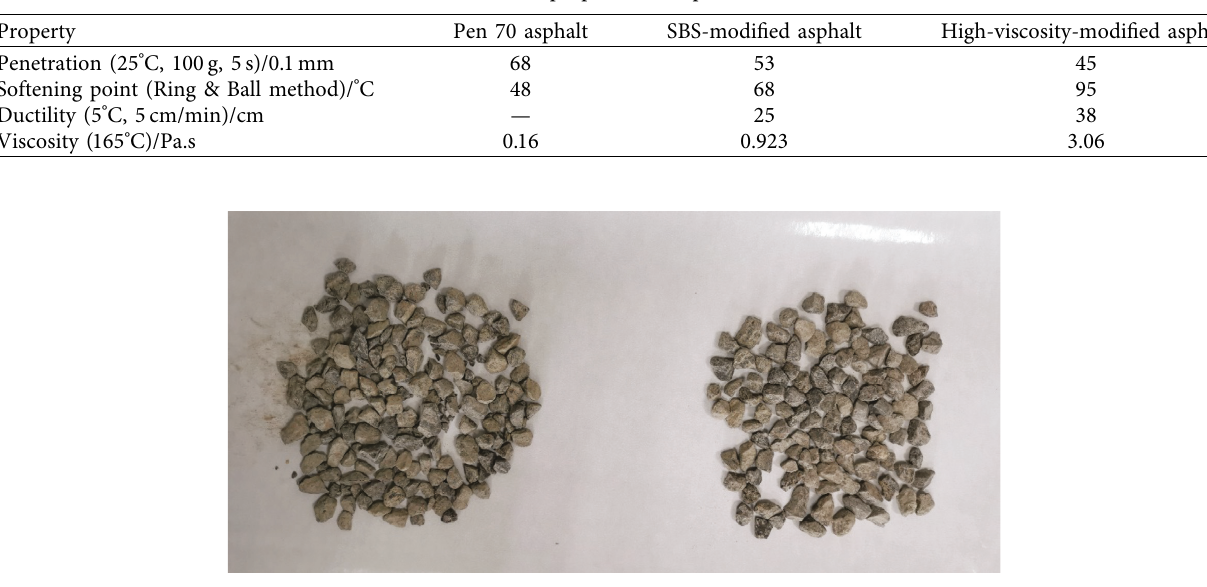
Figure 2: Aggregates (left: before being seized; right: after being seized). Table 2: Air voids of cylinder asphalt mixture